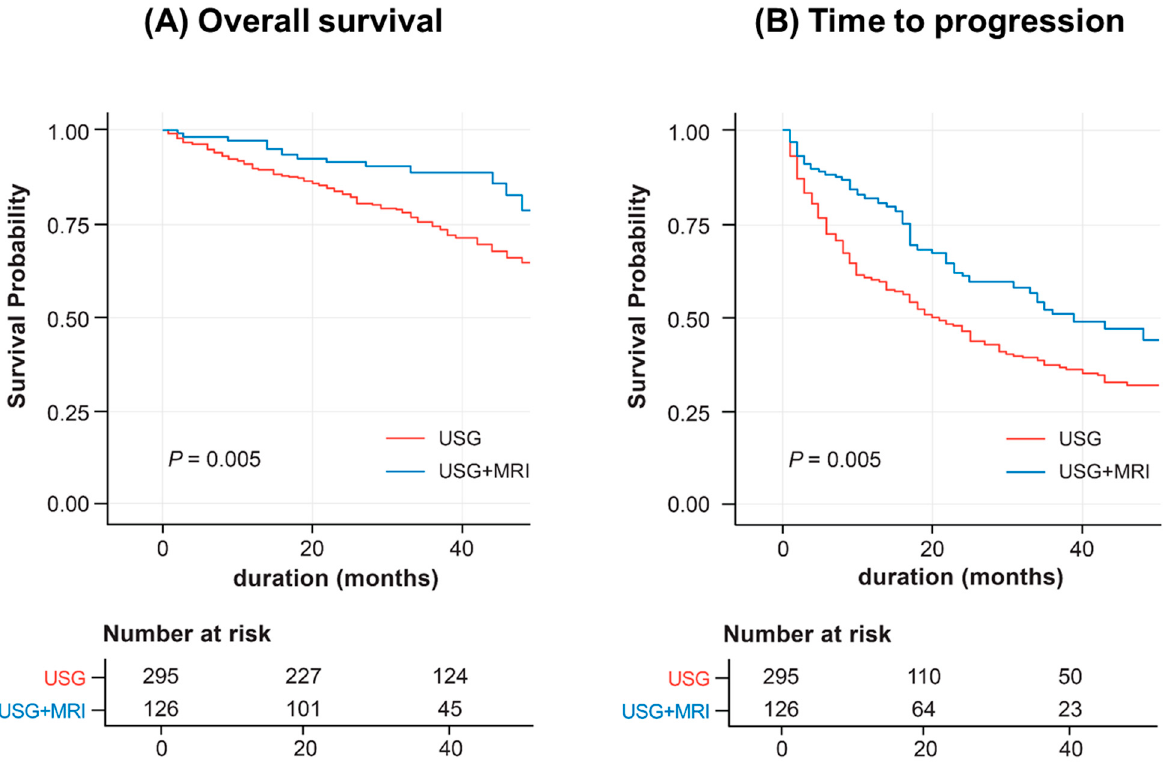
Figure 3. Overall survival and time to progression of patients surveilled with USG alone or USG and Gd-EOB-DTPA-enhanced MRI (IPTW). ( A ) Overall survival. ( B ) Time to